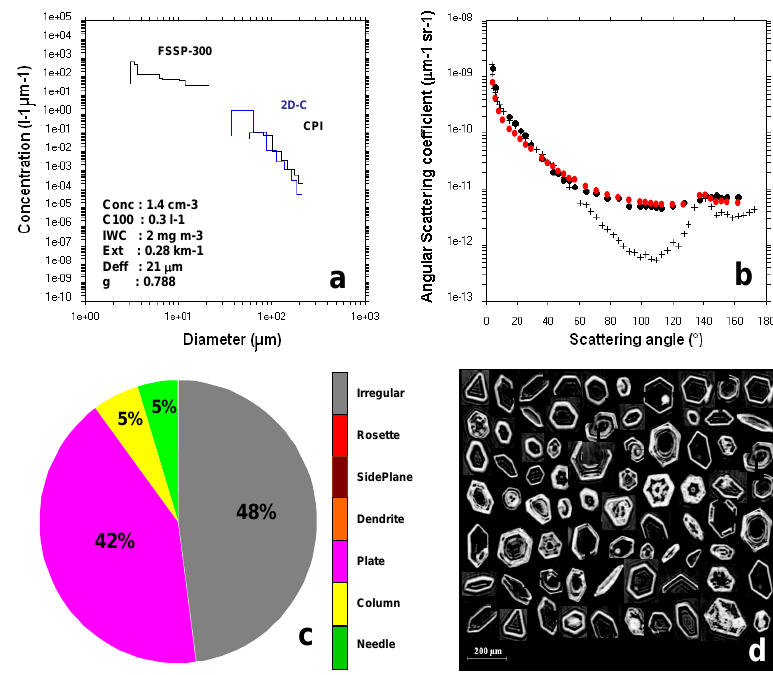
Fig. 2. Mean cirrus cloud properties averaged between 13:32:15 and 13:47:20 (see Fig. 1). (a) FSSP-300, 2D-C (blue) and CPI (black) particle size distributions with averaged values of microphysical and optical parameters; (b) scattering phase function measured by the Polar Nephelometer (filled black circle symbols) and theoretical phase function (cross symbols) calculated from the FSSP-300 size distribution assuming (spherical) ice crystals. Filled red circles are modelled points (Shcherbakov et al., 2006a) from observed crystal shapes (see discussion in Sect. 4). (c) Pie-chart representation of the averaged particle shape classification (in terms of surface particle); (d) illustrative examples of ice particle images from the CPI